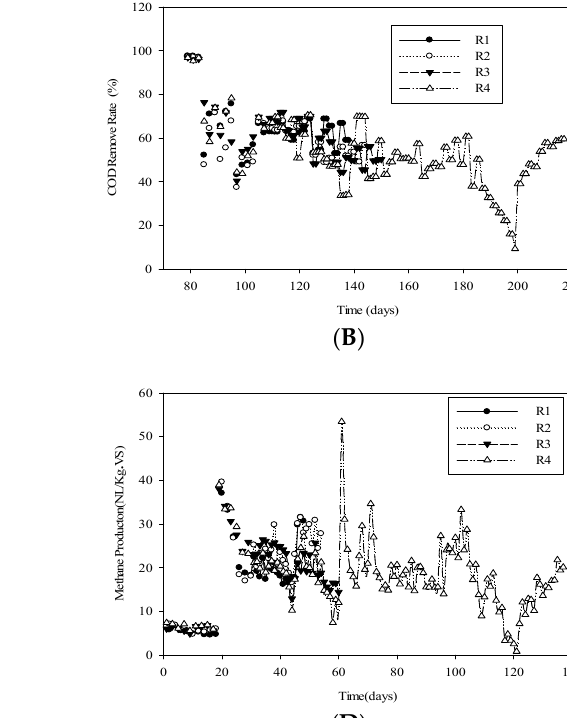
Water 2021 , 13 , x FOR PEER REVIEW Figure 2. Changes in bioreactor performance over time during the operating period including the following parameters: ( A ) biogas production; ( B ) COD removal rate; ( C ) effluent pH; ( D ) methane production.